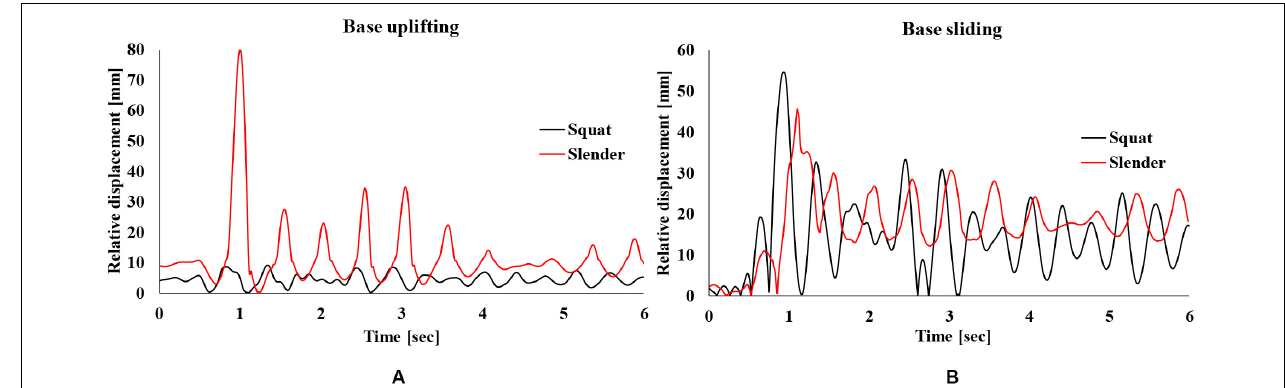
FIGURE 11 | Relative displacement time-histories for the Northern California record for the unanchored ( µ 1 = 0.4) squat and slender tanks for soft soil conditions: base uplifting (A) and base sliding (B) .